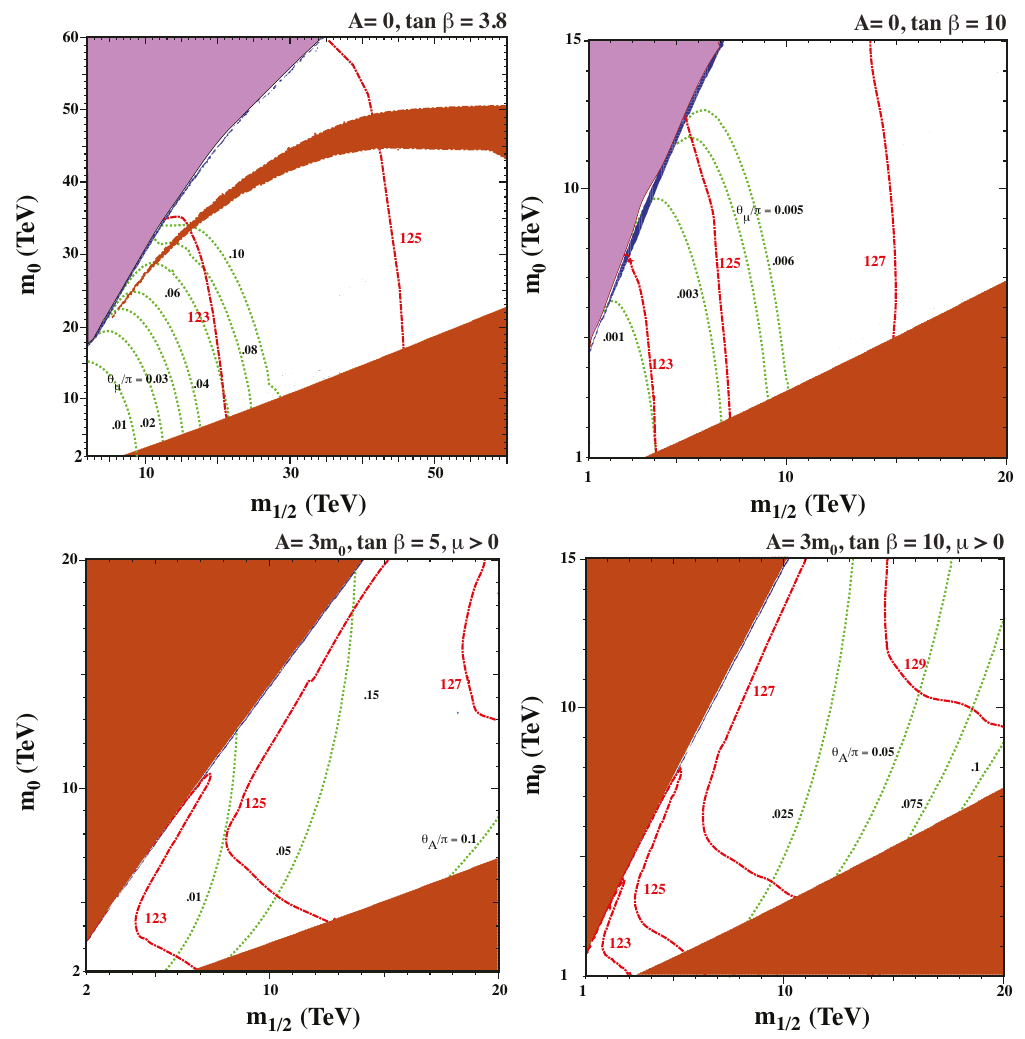
Figure 4 . As in figure 2 using the proton EDM assuming d p < 10 − 29 e panels) and θ A (lower panels) are shown by green dotted